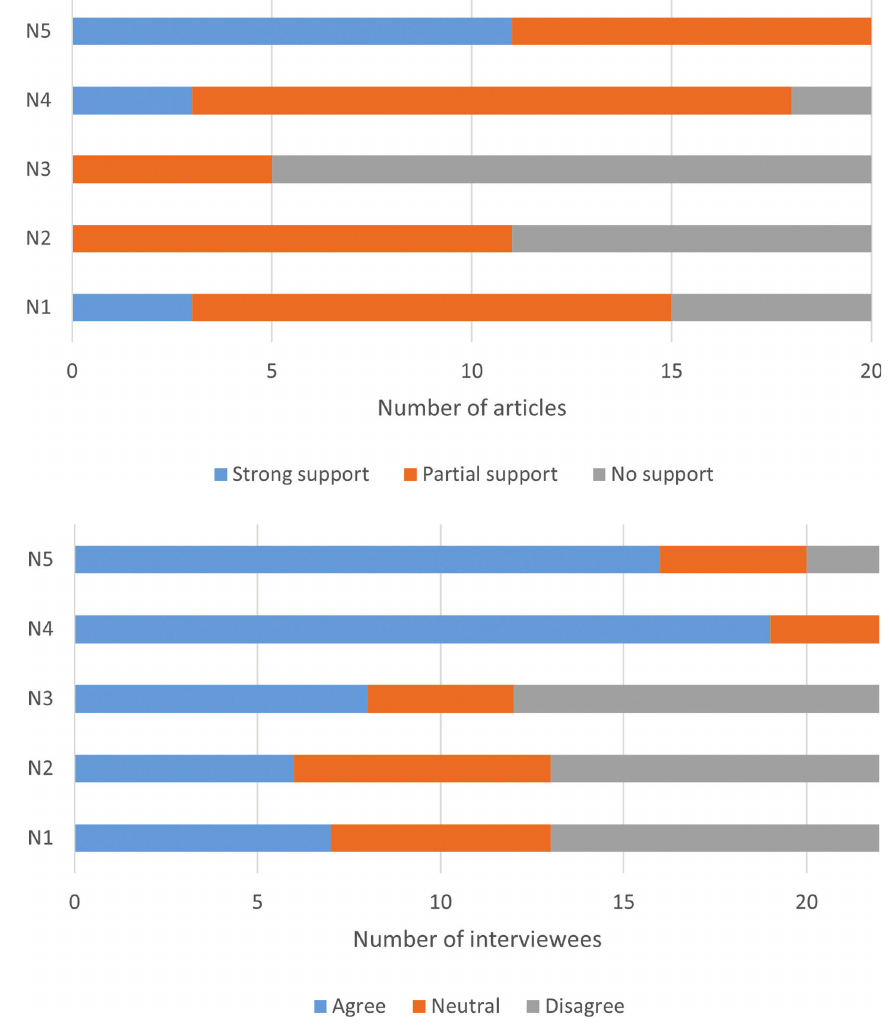
Level of support shown by articles for each narrative.